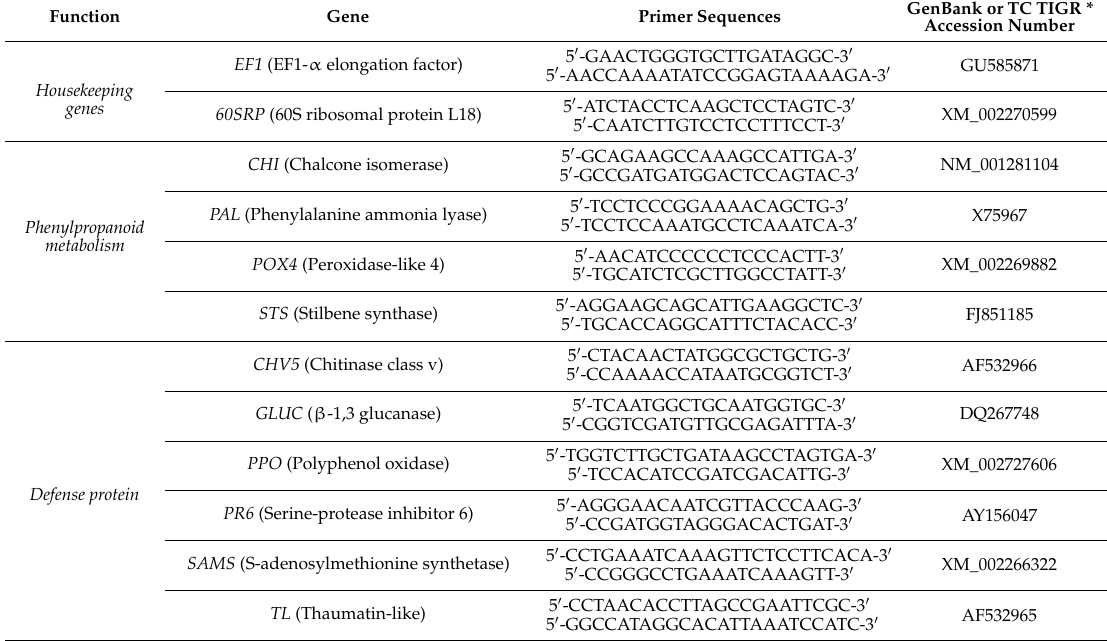
Table 2. Primers of genes analyzed by real-time reverse-transcription polymerase chain